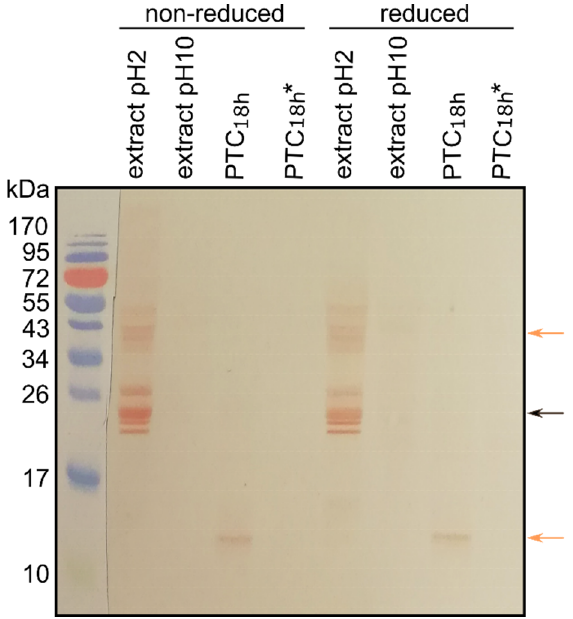
Figure 3. Cross-reactivity of mealworm protein extracts and the serum of a clinically allergic dog. The representative immunoblot shows cross-reactivity between CA canine serum and undigested (extraction at pH 2 or pH 10) and in vitro fully digested mealworm protein acidic (PTC 18h ) or alkaline (PTC 18h* ) extracts. Orange arrows point to protein bands where differences between sera from CH and CA dogs were observed. Black arrow points to the group of mealworm proteins detected by all canine sera. Table 2. Correlation between clinical signs of allergy in dogs, the presence of anti-mite IgEs in their sera and the cross- reactivity of the sera with proteins in mealworm protein acidic extract. Mite-specific IgEs ( T. putrescentiae and A. siro ) were determined with ELISA testing in sera of dogs, clinically healthy (CH) or allergic (CA) ones. One serum with borderline values of anti-mite IgEs in the CH group was not included in the study. In the Western blot experiment, canine sera were then probed for the cross-reactivity with proteins extracted from mealworms at pH 2, before exposure to digestive enzymes and after.